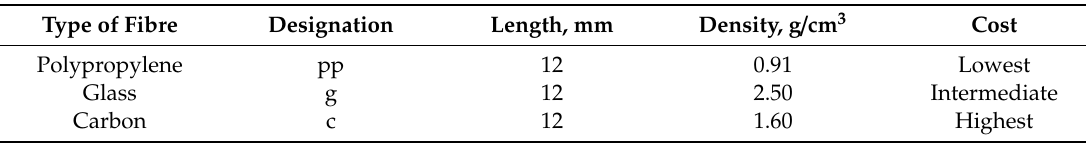
Table 3. Selected properties of fibres used in the tests.